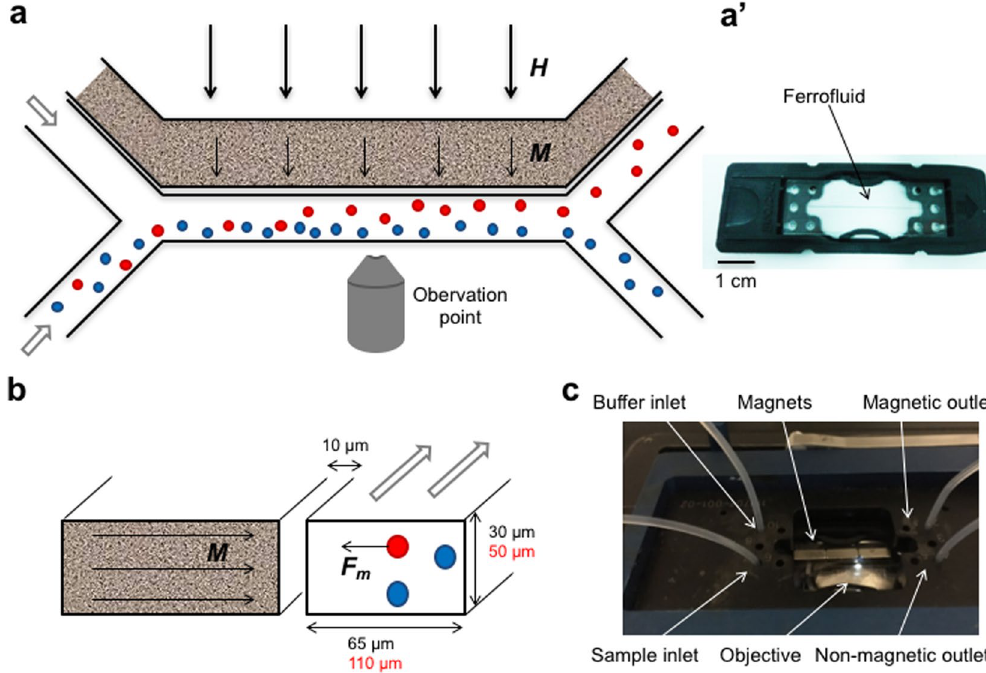
Figure 1. Design of microfluidic sorting device. The microfluidic device is shown from above ( a , a ’) and as a cross section trough the channels ( b ). A ferrofluid is filled in the side channel distanced 10 µ m from the sorting channel ( a’ ). In the presence of an external magnetic field (thick arrows, H ) the nanoparticles in the ferrofluid align to magnetize the ferrofluid (thin arrows, M ) and create a gradient field. This results in an attractive force ( F m ) acting on magnetic cells (red), whereas non-magnetic cells (blue) continue in the sample flow ( a and b ). The small magnetotactic bacteria were tested in a sorting channel with reduced dimensions (black) compared to dimensions used for macrophages (red). The microfluidic chip ( a’ ) is placed inside a chip holder to ensure stable connection of the tubing and placed under a fluorescent microscope for online monitoring of the separation process ( c